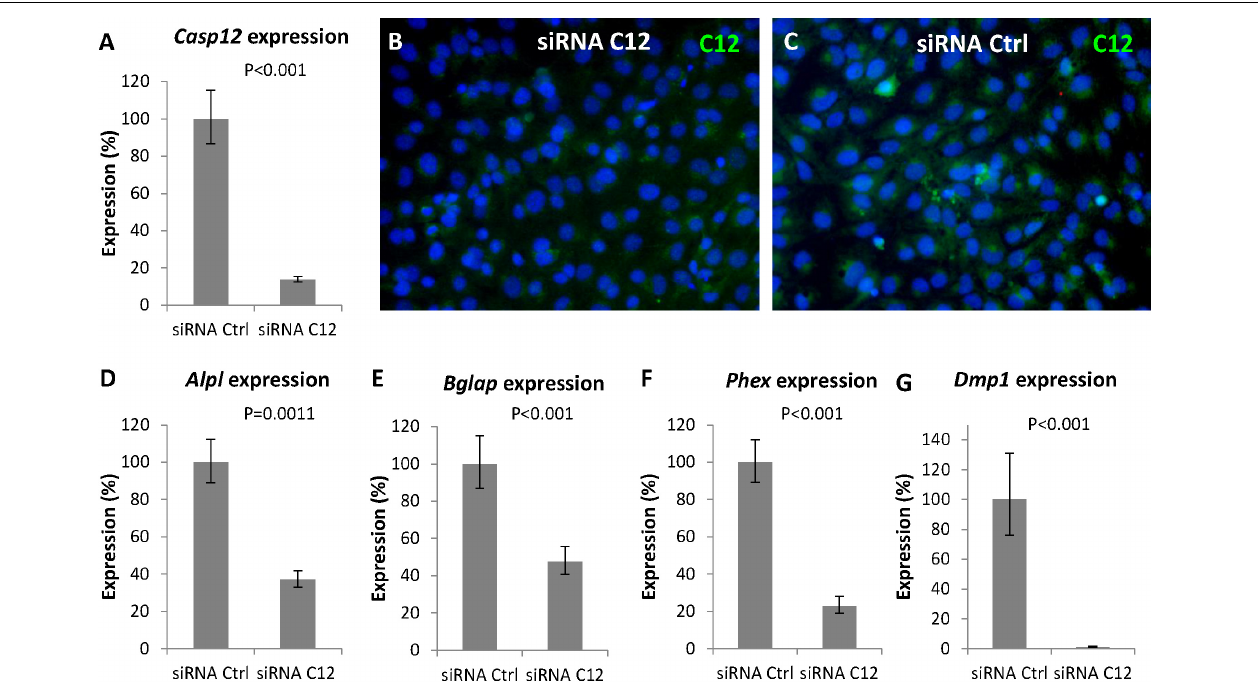
FIGURE 6 | Gene silencing of Casp12 in MC3T3-E1. Gene silencing of Casp12 in MC3T3-E1 cells using specific siRNA showed statistically significant reduction of Casp12 expression (A) . Real-time PCR confirmed statistically significant decrease in expression of Alpl (D) , Bglap (E) , Phex (F) , and Dmp1 (G) after Casp12 silencing. Results are presented as means ± standard deviations and were analyzed using two-tailed t -test. Immunofluorescence detection of caspase-12 (green) protein in MC3T3-E1 after Casp12 gene silencing (B) compared to control (C) , DAPI in